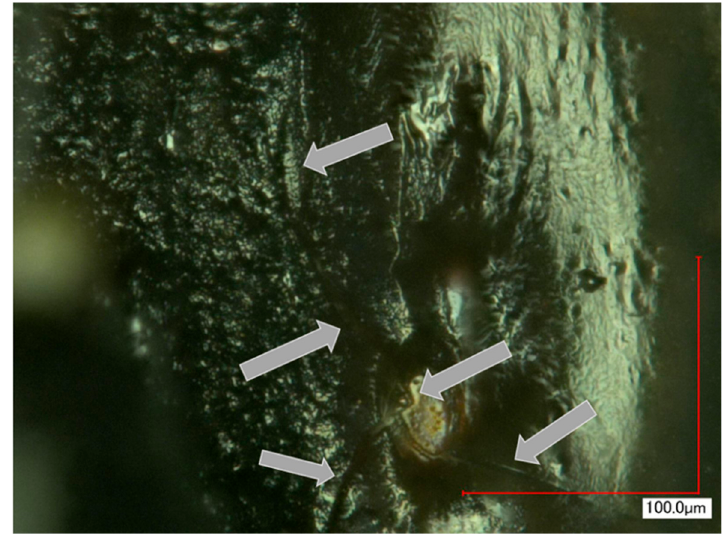
Figure 15. The micro-cracks formed in the adhesive after hours of operation.